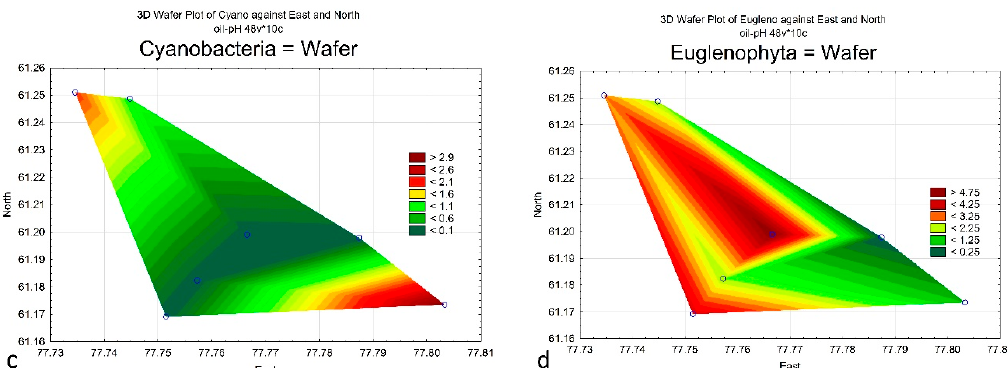
Figure 4. Distribution maps for species richness of Bacillariophyta ( a ), Chlorophyta ( b ), Cyanobacteria ( c ), and Euglenophyta ( d ) algae in seven studied sites of the bogs of the Ershov oil field in the Vakh River basin of the KMAO-Yugra.